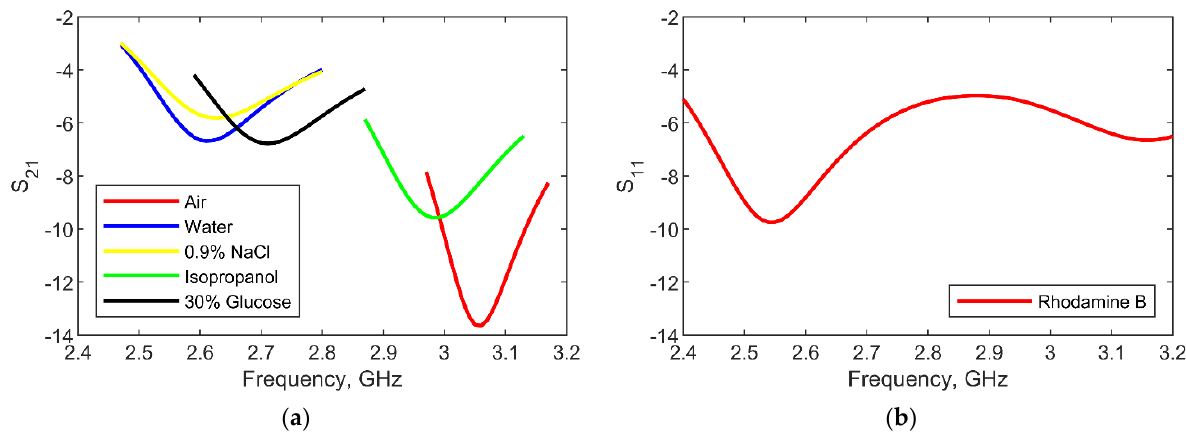
Figure 5. ( a ) Transmission measurements of the CSRR loaded in the microwell with air, demineralized water, physiological liquid (0.9% NaCl), 30% Kela glucose solution and isopropyl alcohol. ( b ) Reflection measurements of the CSRR loaded in the microwell with a mixture of water and Rhodamine B.